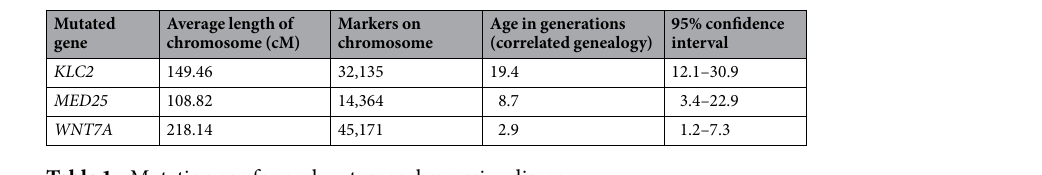
Table 1. Mutation age for each autosomal recessive